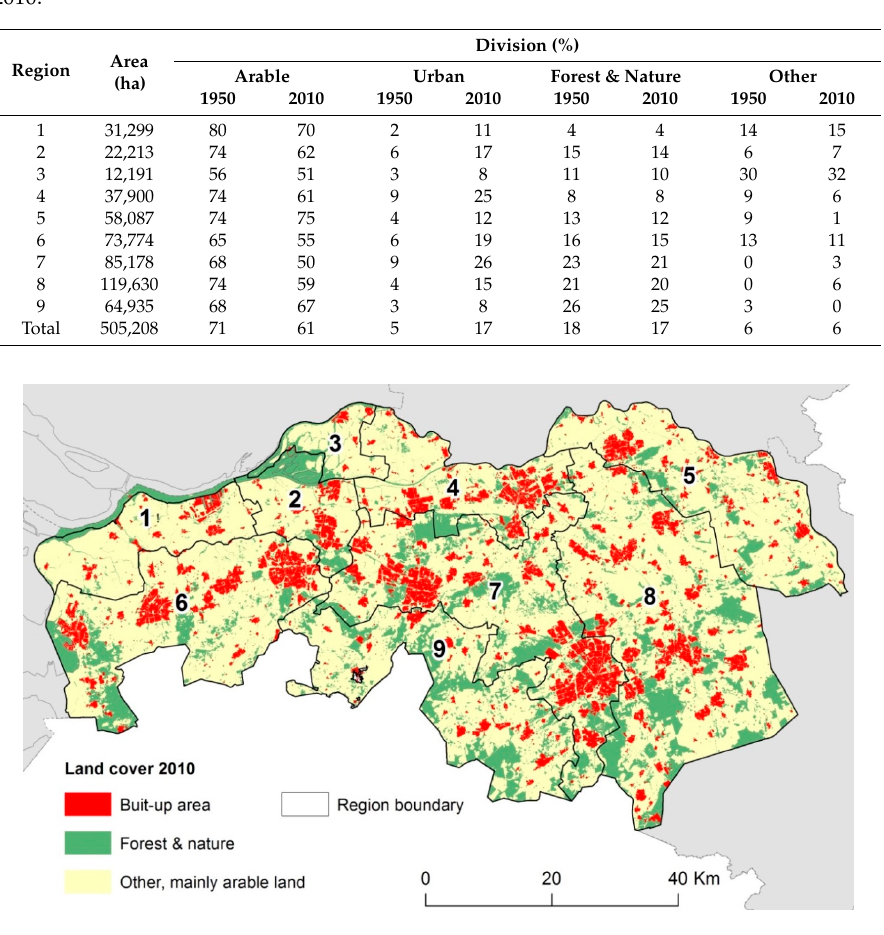
Figure 2. Main categories of land use in 2010 and division of the province of Noord-Brabant into regions for which CBS Statistics issued figures about crop production (Table 1). Source: CBS, 2010. Table 1. Total area and division in main categories of land use of the regions of Figure 2. Source: CBS, 2010. Table 2. Area division of main crops in the province of Noord-Brabant.